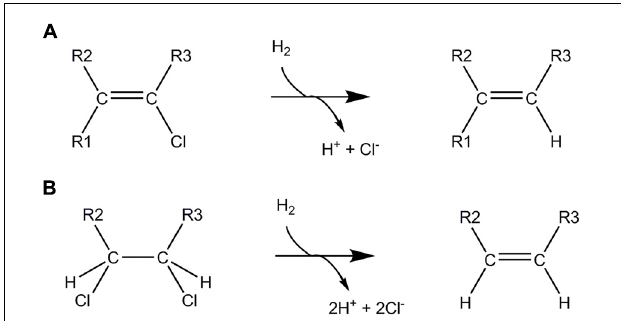
FIGURE 5 | Anaerobic dehalogenation mechanisms. Reductive dechlorination by (A) hydrogenolysis, (B)